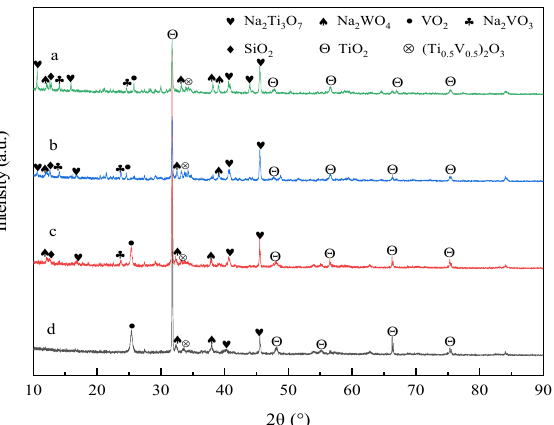
Figure 9. The XRD spectra of roasted clinker at different roasting temperatures: (a) 750 °C, (b) 650 °C, (c) 550 °C, and (d) 450 °C.